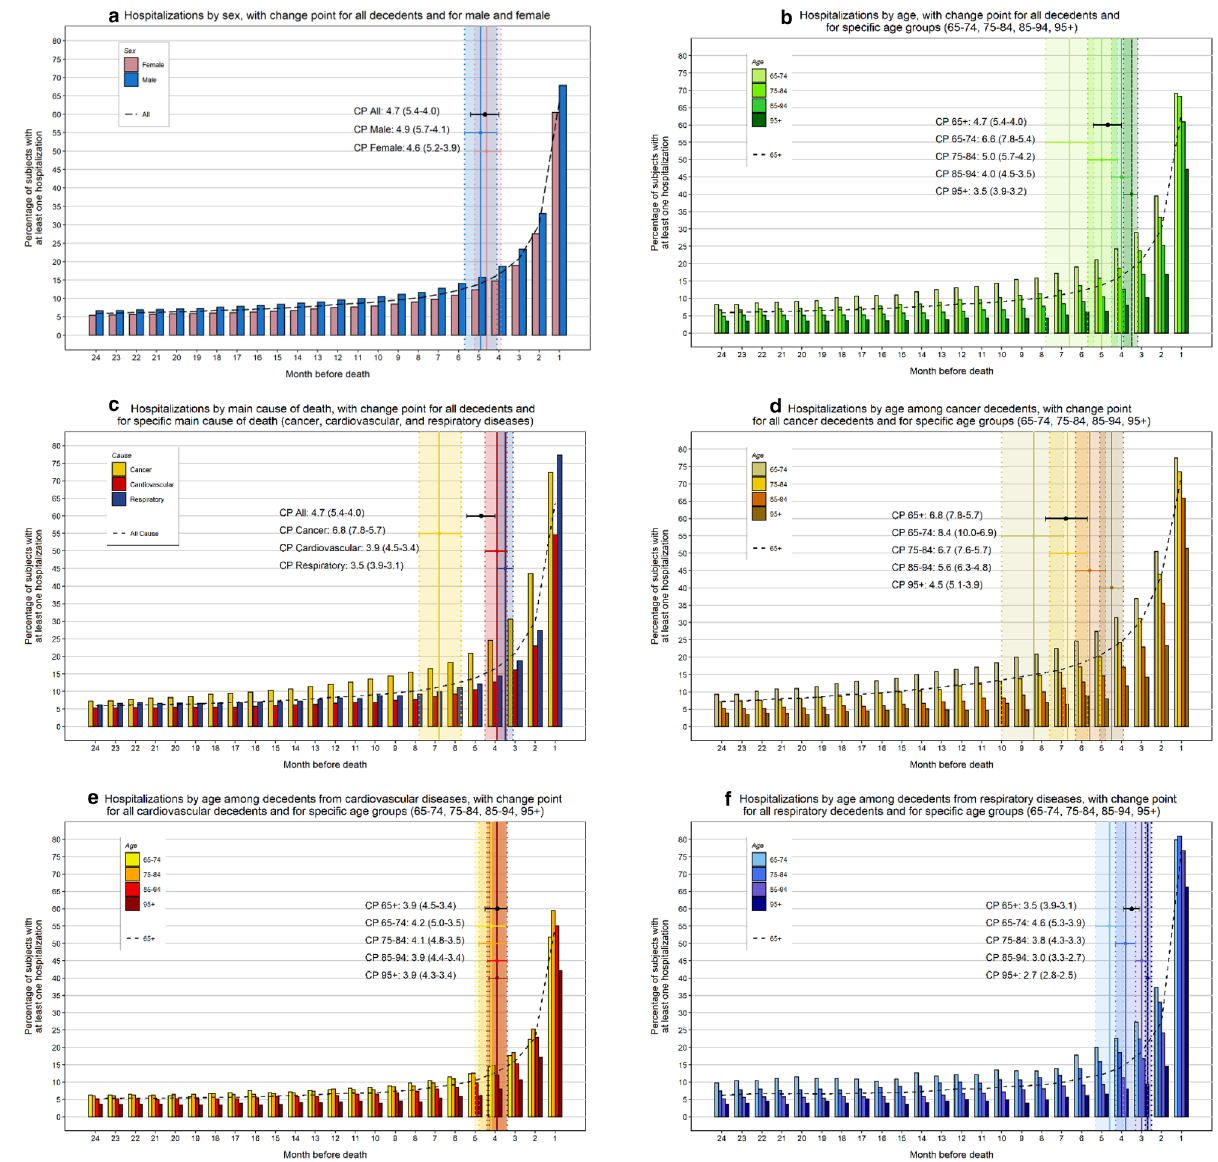
Figure 1. Proportion of hospitalized decedents stratified by sex, age and main cause of death, in the 24 months preceding death, with specific change-point month and 95% confidence